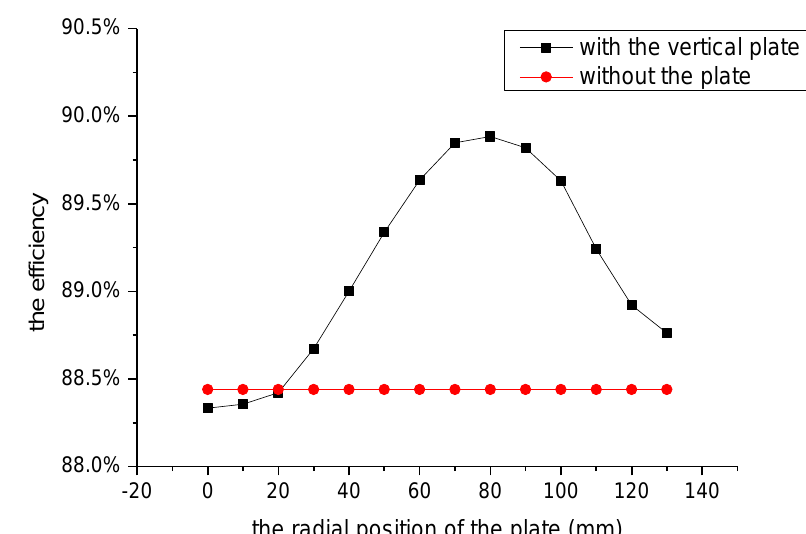
Figure 7. The variations of the system efficiency on the radial position of the vertical plate.